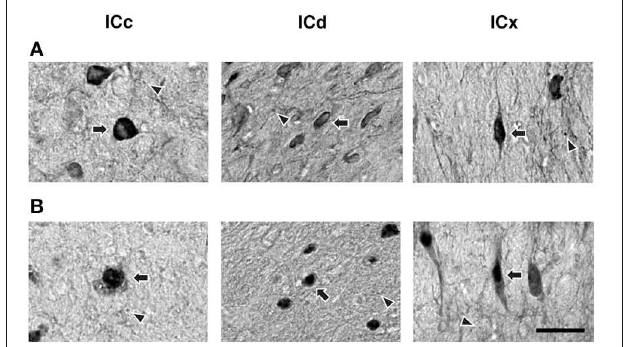
FIGURE 5 | High magnification photomicrographsshowing GABA B R1 and GABA B R2 immunoreactivity (A and B) in the ICc, ICd, and ICx. Arrows point toward labeled cell bodies while arrowheads point toward labeled puncta in the neuropil. Scale bars: 25 μ